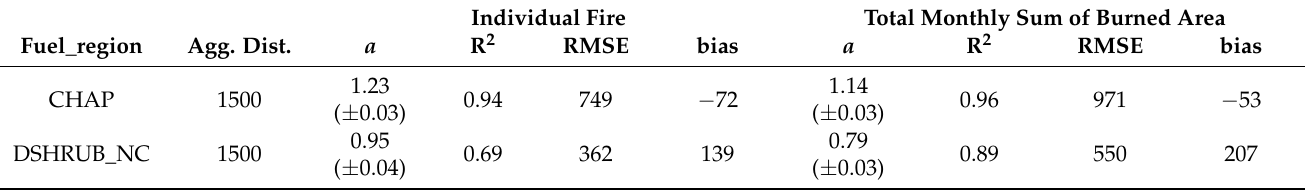
Table 2. Coefficients and goodness-of-fit statistics of the best models when comparing burned area with aggregated fire perimeters produced with active fire data for each fuel and region. Individual